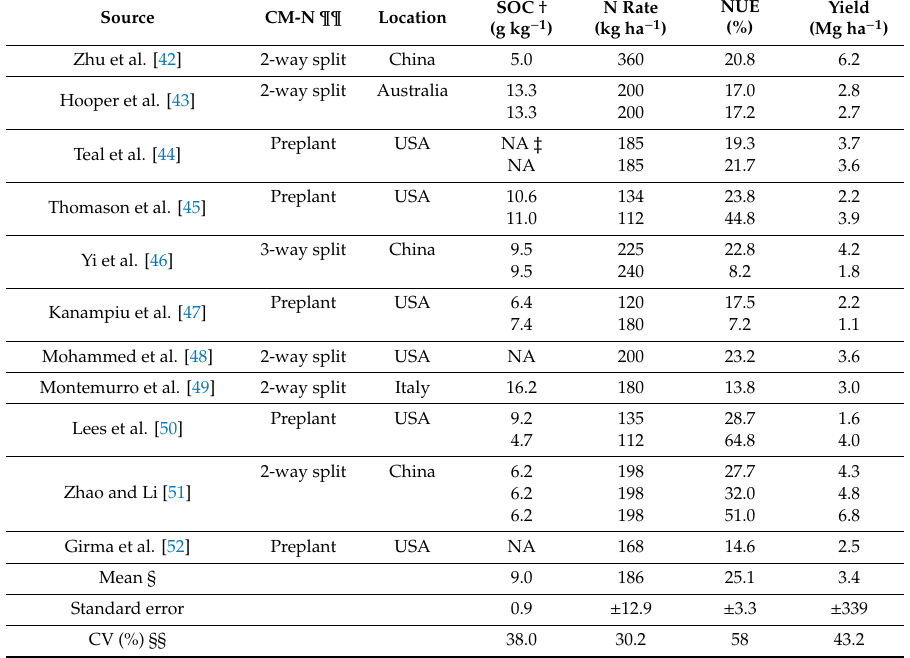
Table 2. Peer-reviewed research publications used to compute NUE and grain yield at selected rates that some producers are expected to apply using conventional methods of N